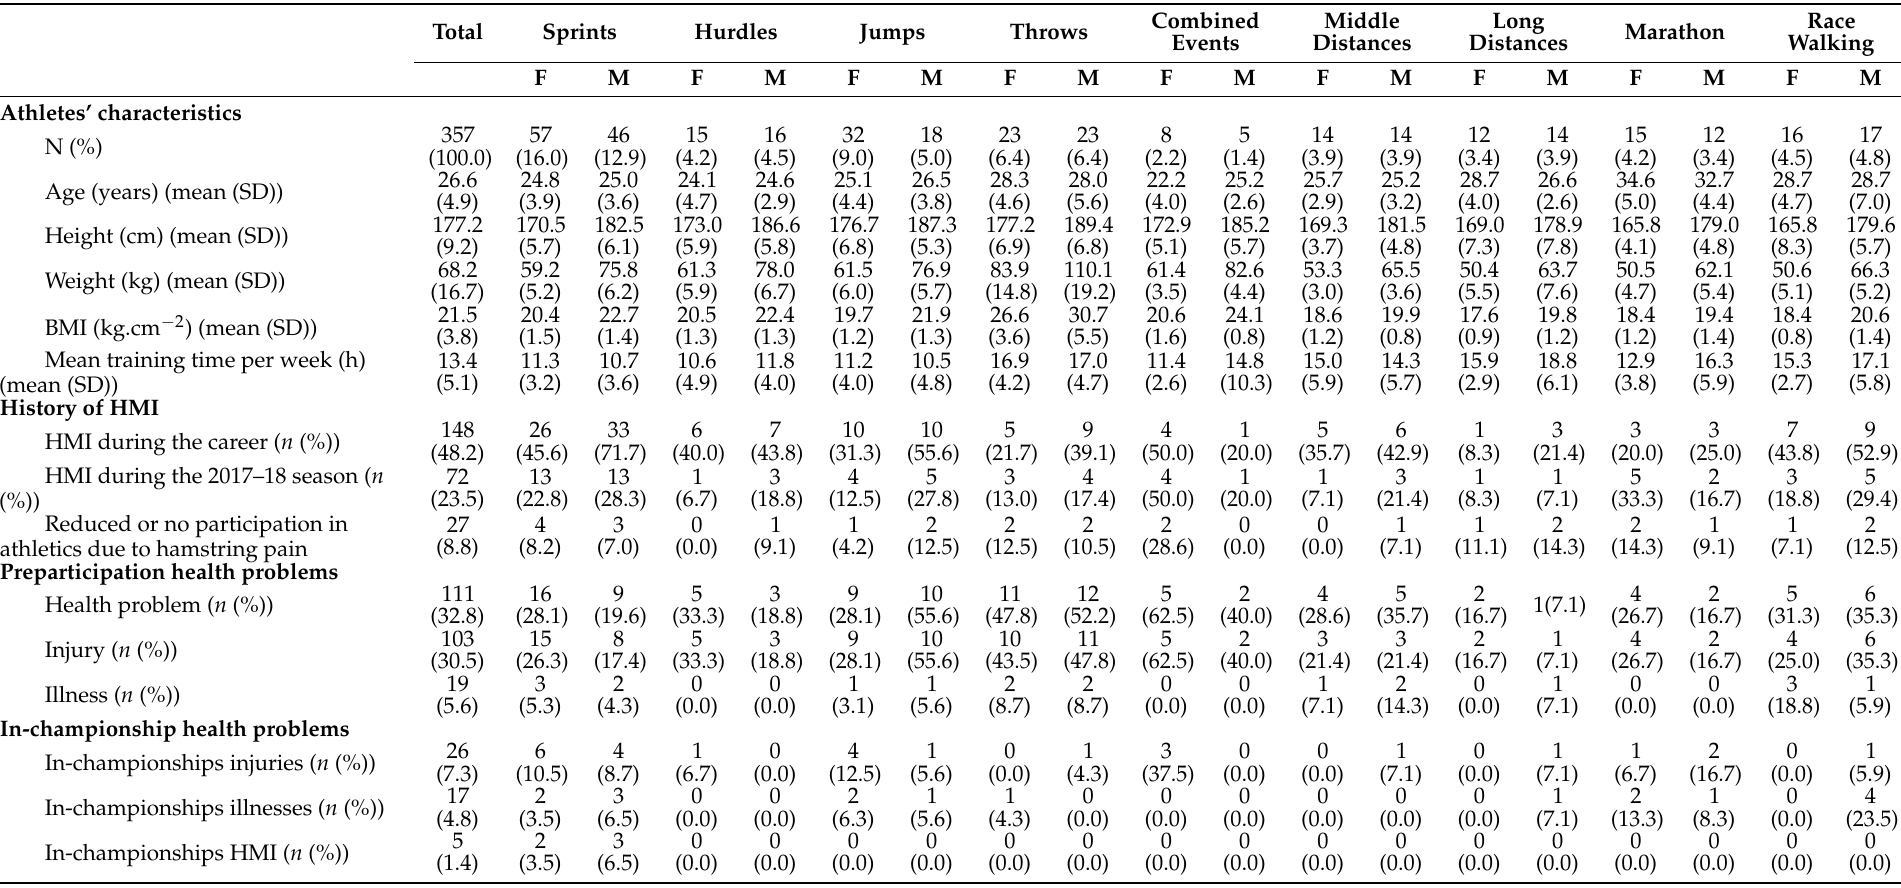
Table 1. Characteristics of the 357 included athletes who participated at the 24th European Athletics Championships in Berlin in 2018 and who were included in the present study, as well as their history of hamstring muscle injuries (HMI), preparticipation health problems and in-championships injuries, illnesses and hamstring muscle injuries. Data are presented using mean with standard deviations ( ± SD) for continuous variables and using number and frequency with percentages for categorical